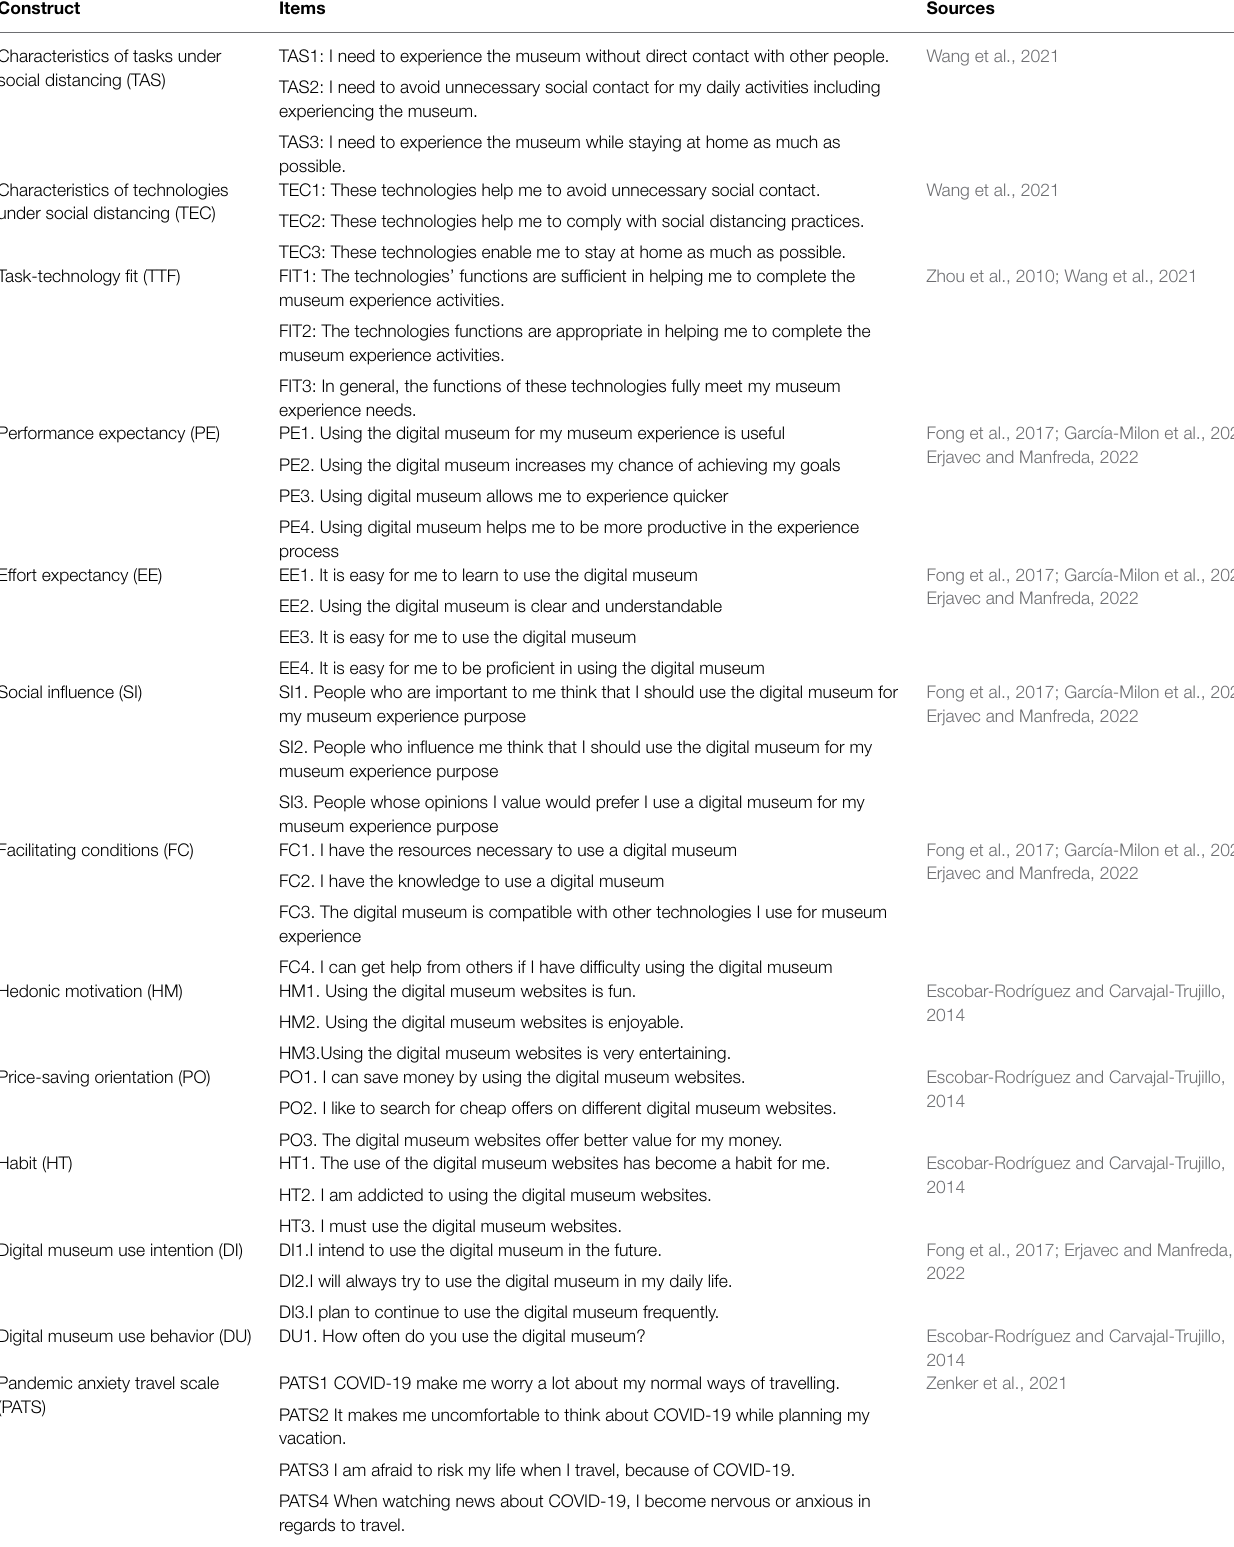
TABLE 1 | Measuring scales. Construct Items Sources Characteristics of tasks under social distancing